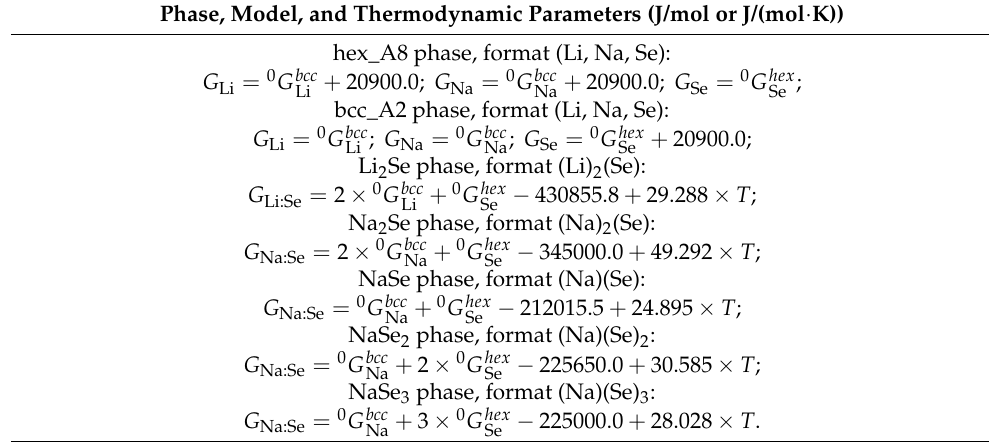
Table 4. Optimized thermodynamic parameters of solid solutions and compounds in the Li-Se and Na-Se binary systems.